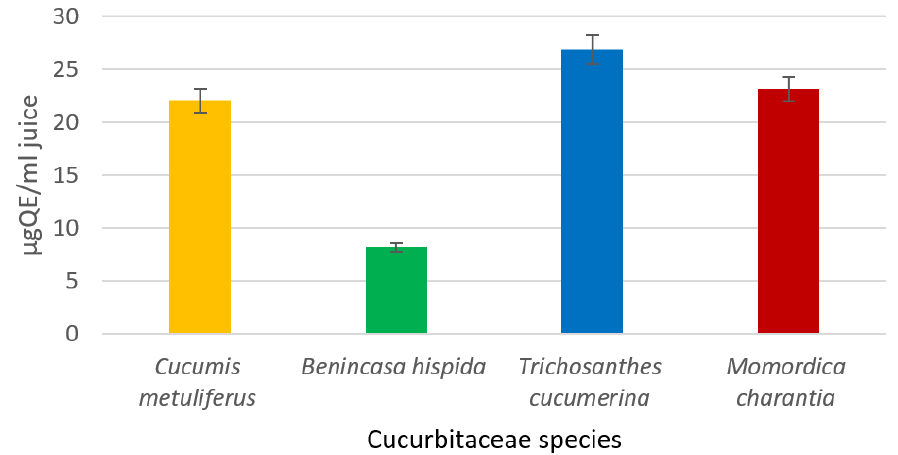
Figure 3. Total flavonoids content of tested samples. The error bars represent ± standard deviation of three replicates.